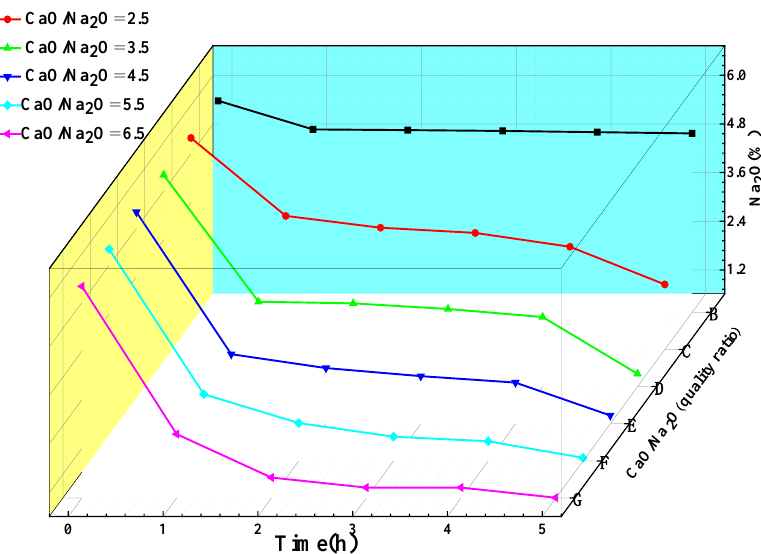
Figure 11. Effect of reaction time on dealkalization rate.